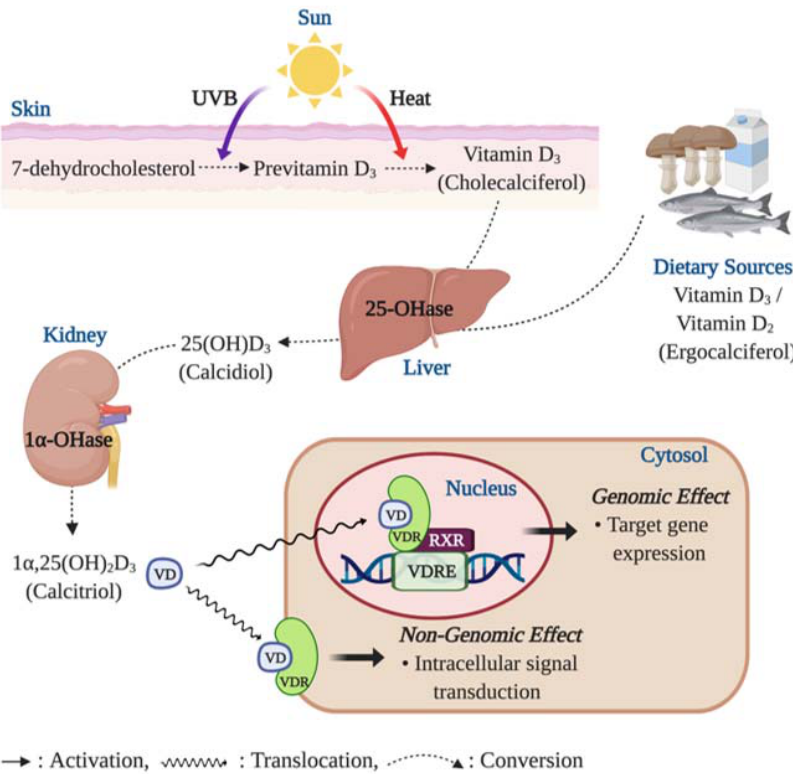
Figure 1. Basic physiology of vitamin D action. Humans obtain vitamin D mainly through endogenous production of previtamin D 3 and vitamin D 3 in the skin, followed by subsequent conversions in the liver and kidney. When exposed to the sun, 7-dehydrocholesterol converts to previtamin D 3 and vitamin D 3 by ultraviolet B (UVB) radiation and heat, respectively, in the skin. A small amount of vitamin D can be present in natural food as vitamin D 2 and D 3 . Vitamin D 2 / D 3 go through hydroxylation two times in the liver (vitamin D 2 / D 3 → 25 (OH) D 3 ) and the kidney (25 (OH) D3 → 1 α ,25 (OH) 2 D 3 ) to become a biologically active form of vitamin D 3 , 1 α ,25 (OH) 2 D 3 ;1 α ,25 (OH) 2 D 3 exerts its biological actions by binding to the nuclear vitamin d receptor (VDR), which associates with a retinoid x receptor (RXR) in the nucleus. The VDR / RXR heterodimers bind to the vitamin D response element (VDRE) in the promoter region of vitamin D-regulated genes and initiate expression of various genes. VDR is also found in the plasma membrane, and the liganded plasma membrane VDR activates an intracellular signaling transduction involved in many physiological actions.